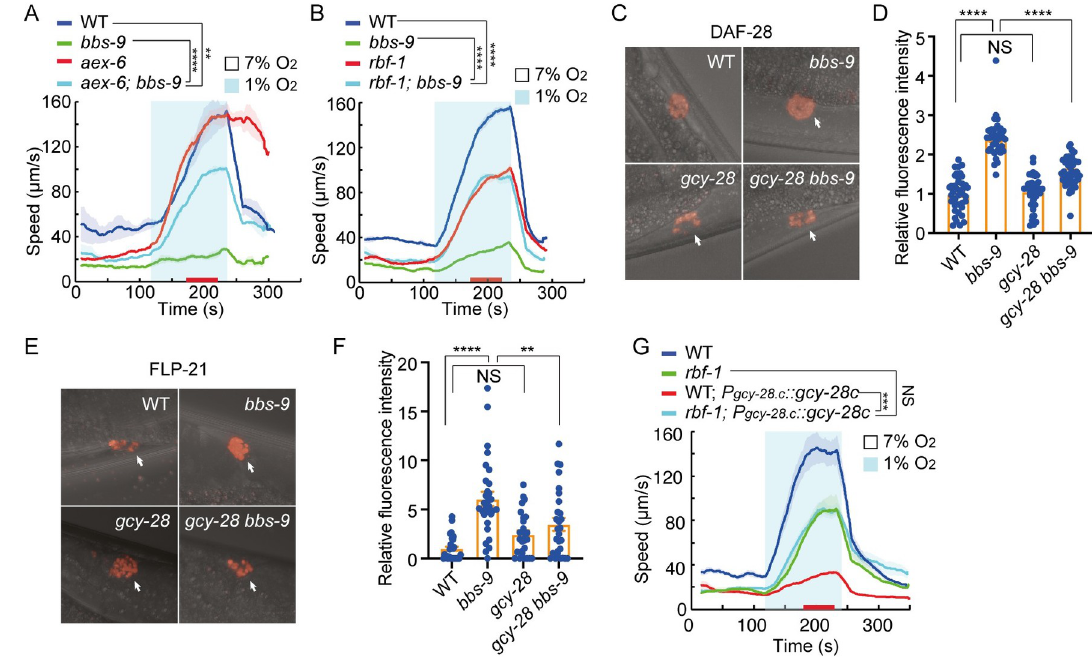
Fig 6. Increased neuropeptide secretion inhibits acute hypoxia responses. (A and B) Locomotory responses to 7% to 1% O 2 stimuli for indicated genotypes: WT, bbs-9(gk471) , aex-6(sa24) , and bbs-9(gk471); aex-6(sa24) double mutants in (A); and WT, bbs-9(gk471) , rbf-1(js232) , and bbs-9(gk471); rbf-1(js232) double mutants in (B). ���� = p < 0.0001, �� = p < 0.01, ANOVA, Tukey multiple comparison. (C) Coelomocyte accumulation of DAF-28-mCherry secreted from ADL neurons in WT, bbs-9(gk471) , gcy-28(yum32) , and bbs-9(gk471) gcy-28(yum32) double mutants. Arrows indicate posterior coelomocytes. (D) Quantification of DAF-28-mCherry fluorescent intensity in one of the posterior coelomocytes. The mCherry intensity in WT ( n = 40) was arbitrarily set to 1, and